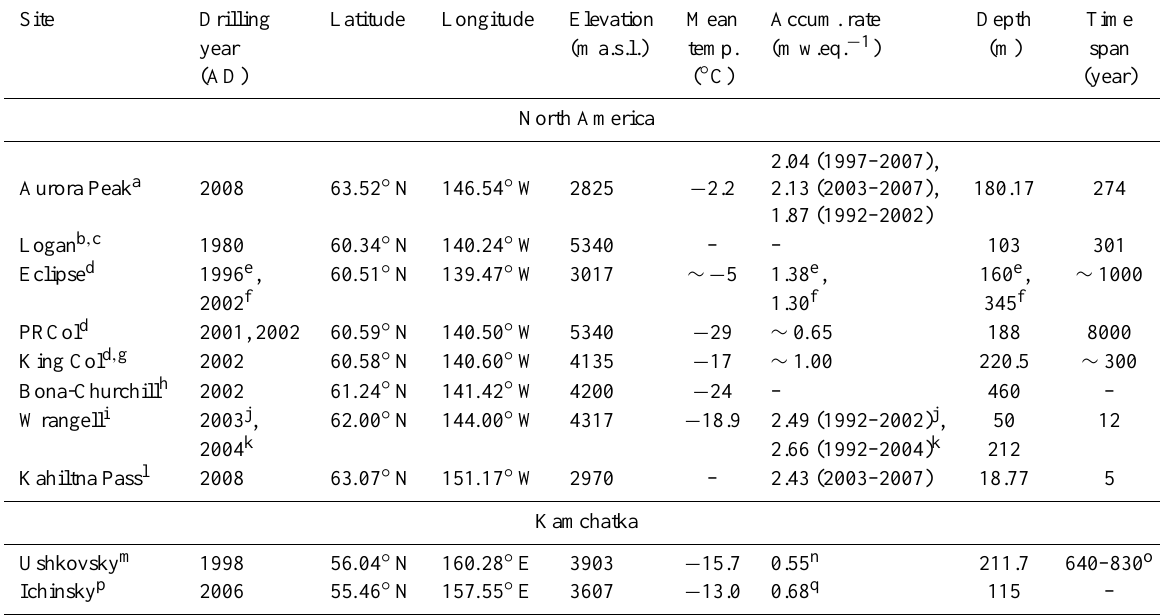
Table 1. Information from the northern North Pacific ice core records. Site